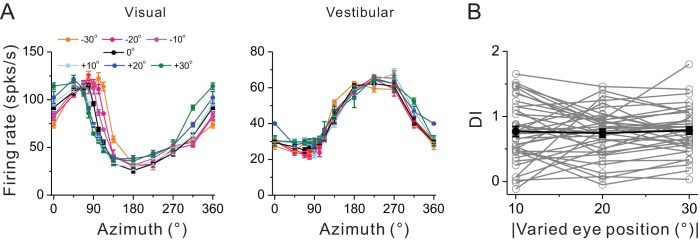
DI measured under a broader range of eccentric fixation task by introducing two extra eccentricities of 10° and 30° in addition to the 20°.(A) An example neuron with heading tuning curves measured under a broader range of eye-in-orbit positions. (B) DI measured under different eccentric fixation (10°, 20°, 30°) are analogous. Gray curves represent the DI values from each cell. Black symbols represent mean and s.e.m.